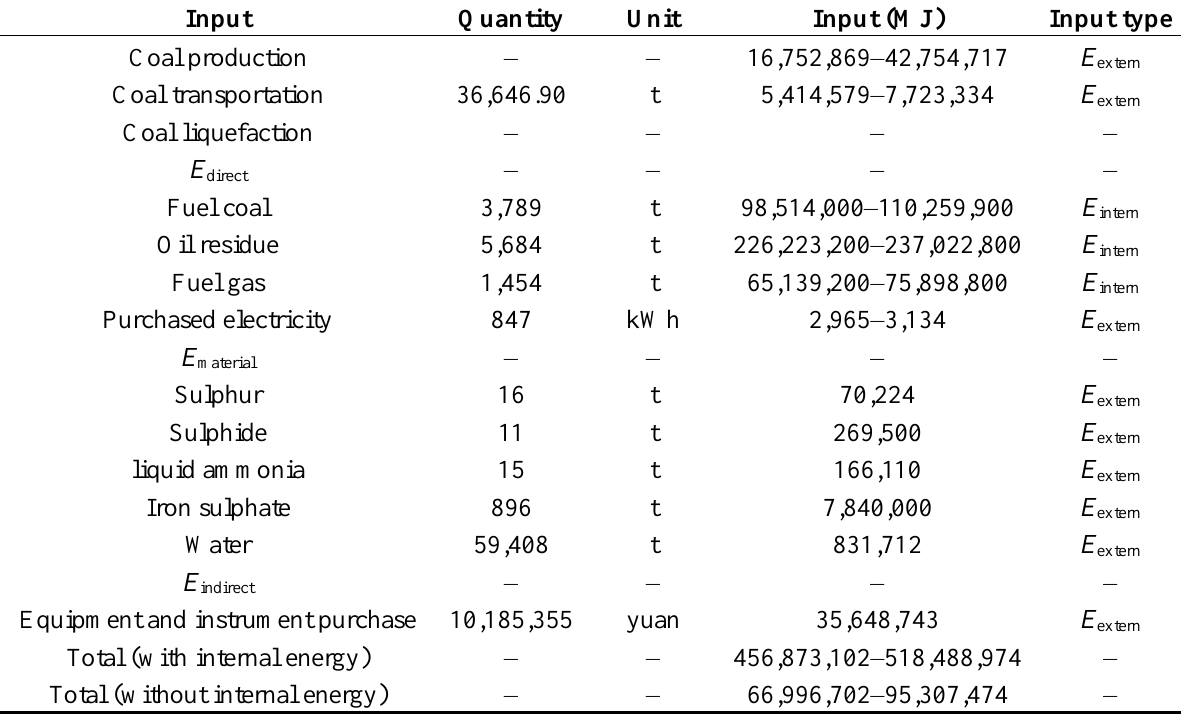
Table 4. Primary energy inputs per 10,000 tonnes of DCL products and our conversion to MJ